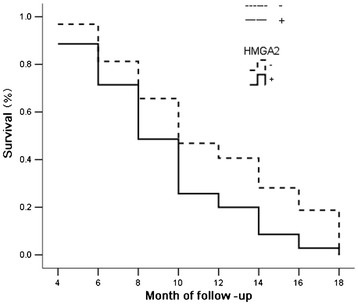
The survival curve of patients with HMGA2-positive or negative expression.